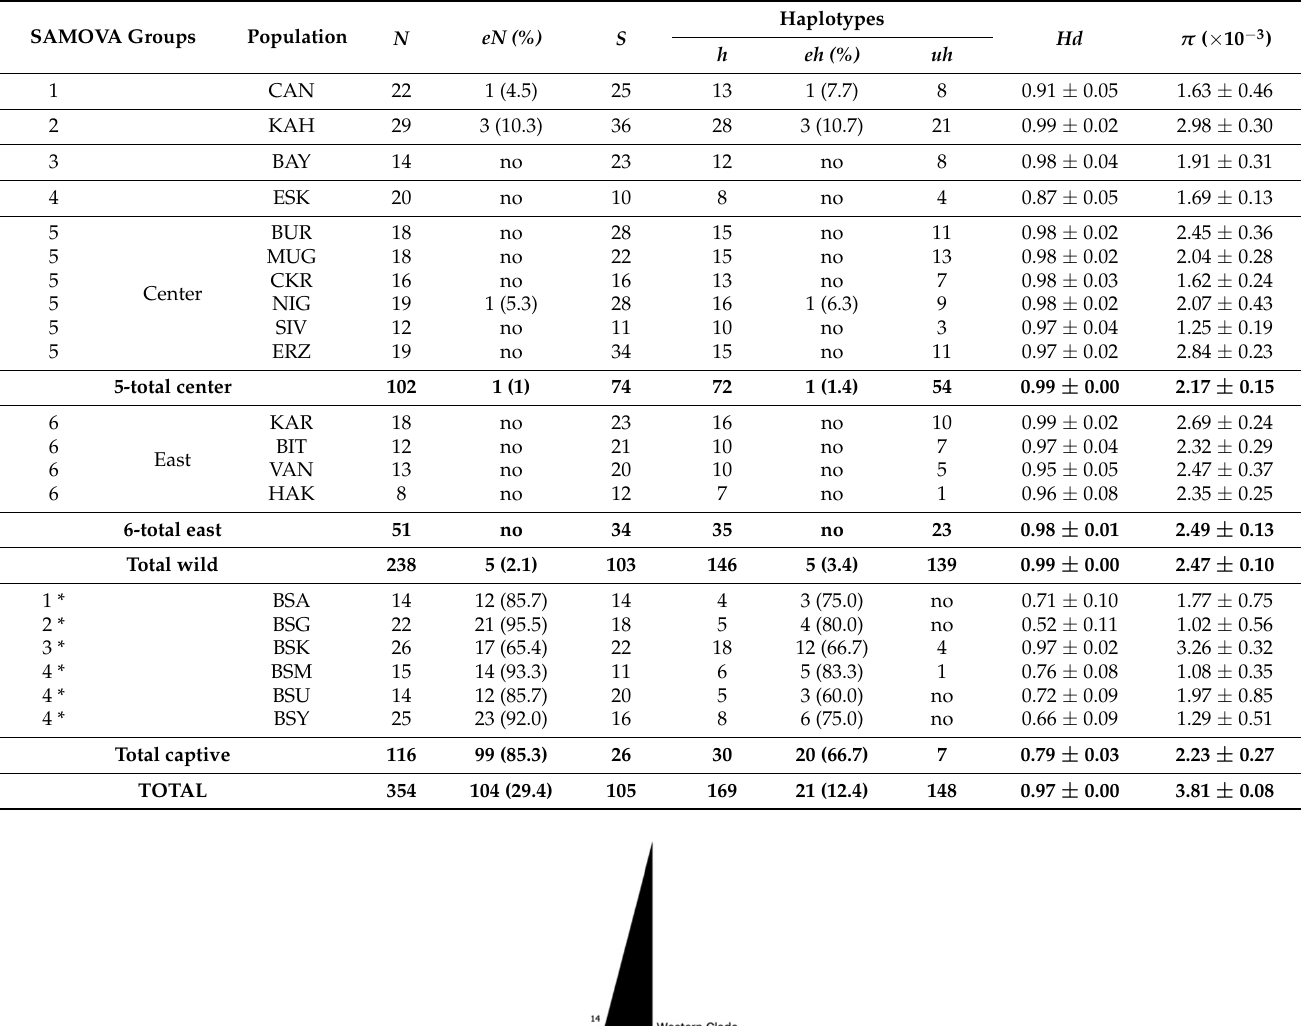
Table 2. Summary statistics ( ± SD) of genetic diversity in Chukar Partridge populations. Haplotype diversity ( Hd ) and nucleotide diversity ( π ) for each sampling area. N = number of individuals; eN = number of east clade individuals; S = polymorphic sites; h = number of haplotypes; eh = num- ber of east haplotypes; uh = number of unique haplotypes. * SAMOVA groups of breeding station.